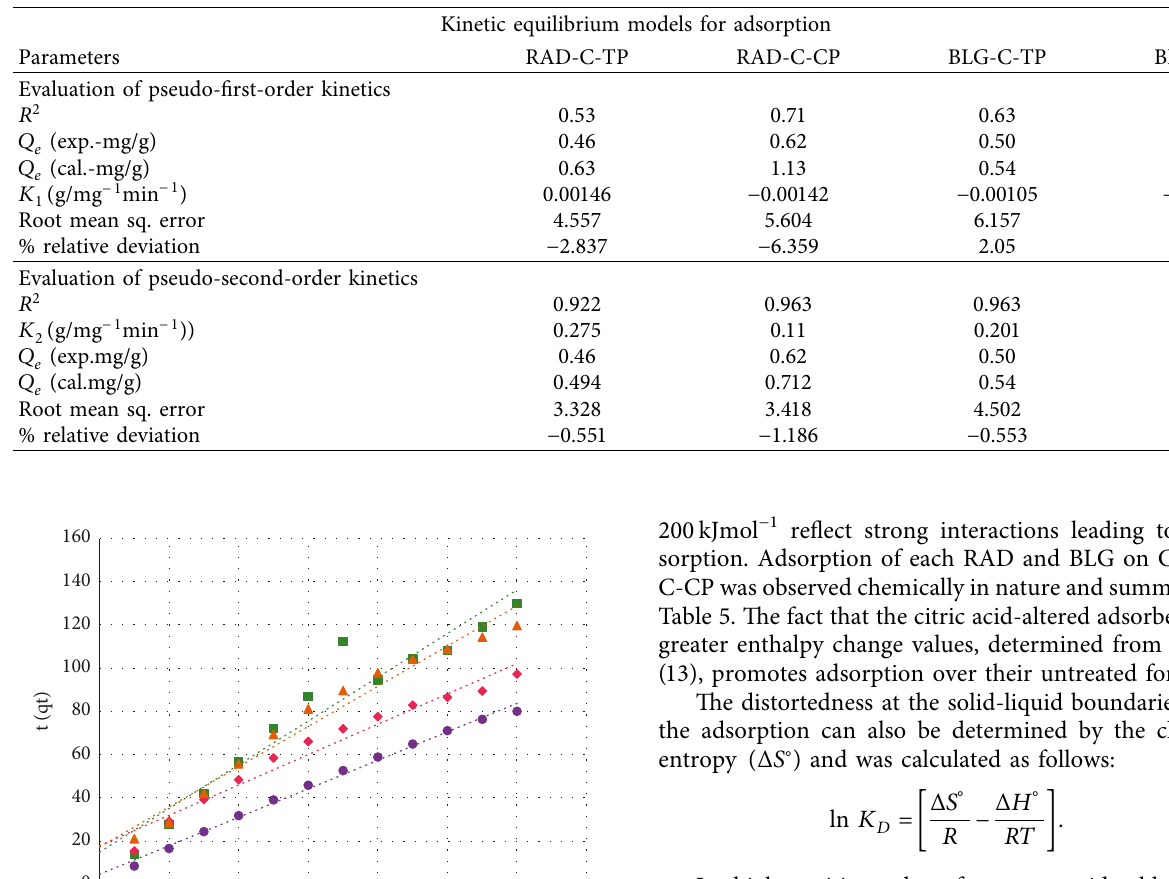
Table 4: A comparison of parameters for kinetics studies.